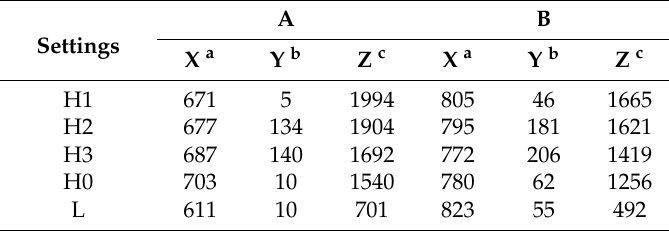
Table 7. Centre of gravity coordinates (mm) in the two tested